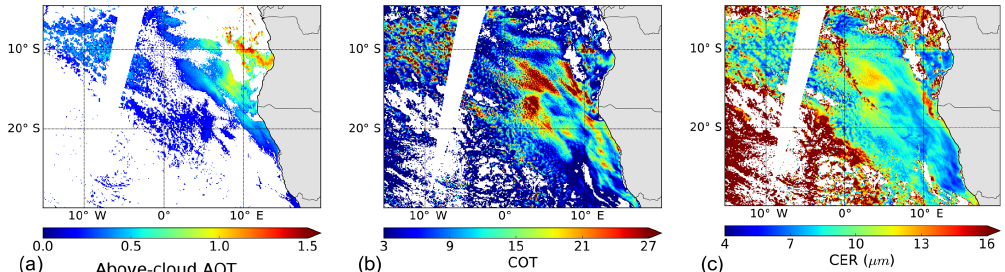
Figure 6. Above-cloud AOT at 0.55µm (a) and cloud properties ( b and c ) retrieved from MODIS Terra with the MOD06ACAERO algorithm (Meyer et al., 2015) on 28 August